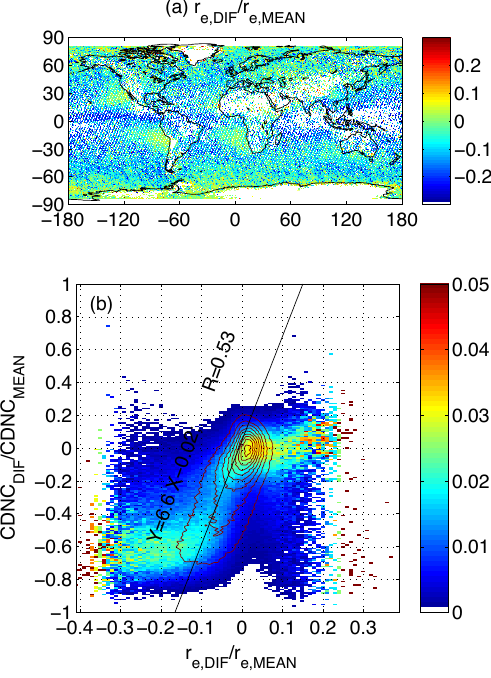
Figure 4. Geographical distribution of the relative difference of effective radius between 3.7µm and 2.1µm bands (a) and two- dimensional histogram between relative CDNC differences and relative effective radius difference between 3.7µm and 2.1µm bands (b) . The color bar represents the normalized pixel number of each bin of effective radius difference. The solid straight line repre- sents the linear relationship, and solid circle lines are isolines of the pixel number.